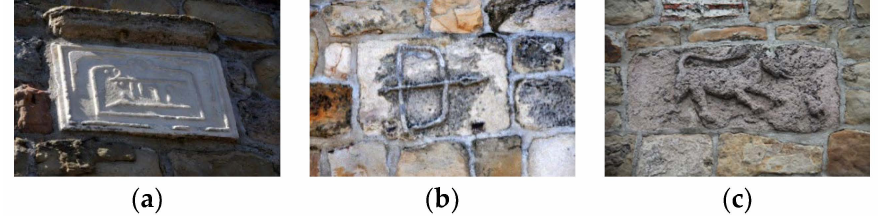
Figure 4. Decorative rosettes on the walls of the Fortress and in buildings, symbols that drive enemies away from the Fortress ( a – c ) (Photo source: private archive of Vladan